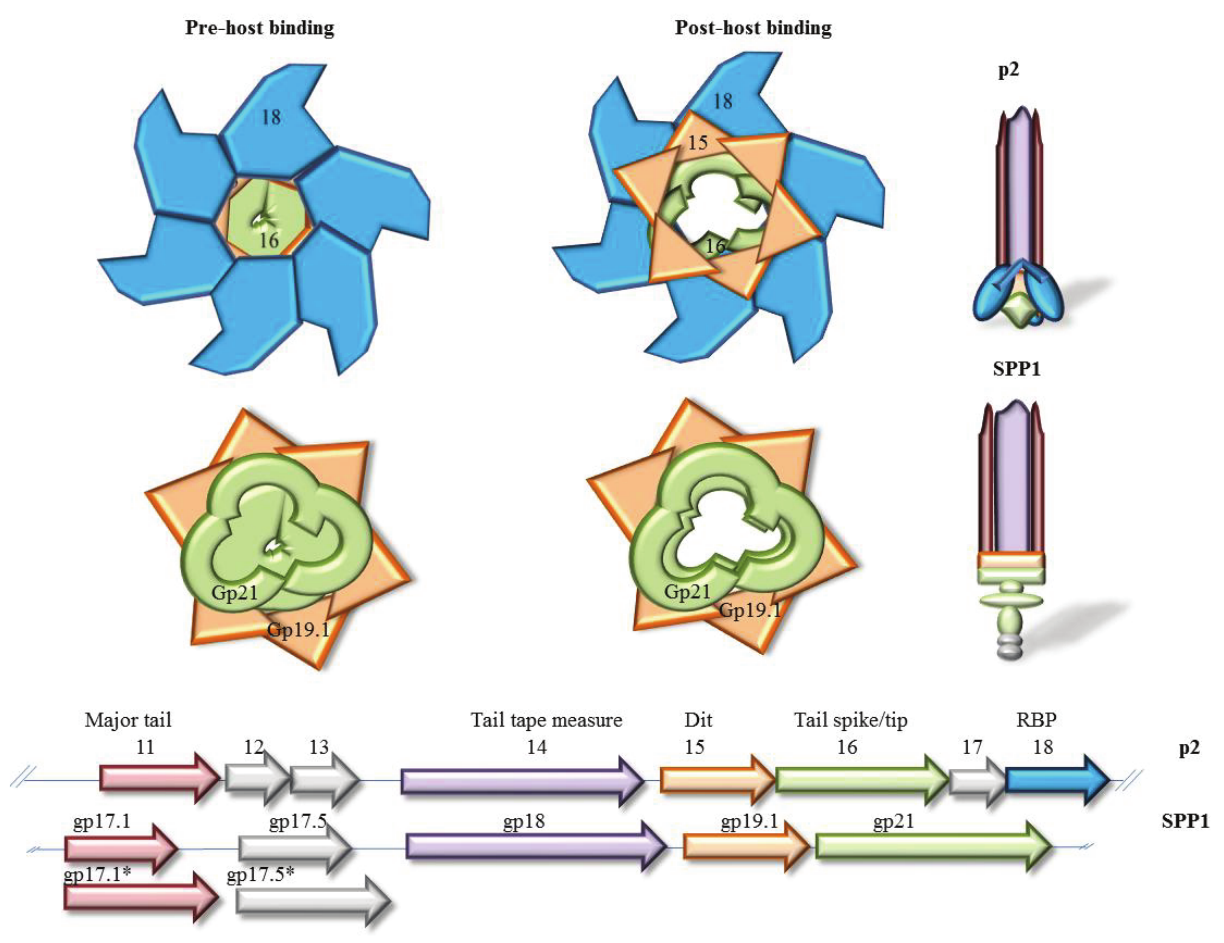
Figure 1. Schematic representation of a top view of the re-organisation of the p2 (top) and SPP1 (bottom) baseplate regions before (right) and after (left) binding to the host cell. The p2 baseplate, composed of a hexamer of ORF15 (orange), a trimer of ORF16 (green) and six trimers of ORF18 (blue) which represents the RBP. In parallel, the SPP1 distal tail region is composed of two back-to-back hexamers of gp19.1 (orange) and a trimer of gp21 (green) bound to each of the Dit (gp19.1) hexamers, one trimer in the open conformation and the other in the closed conformation. A representation of the genomic regions that encode the tail structural components are presented in the lowermost section, including the genes encoding the proposed major tail protein (pink), the tail tape measure protein (purple), the distal tail protein (Dit)/hub protein (orange), the tail spike (SPP1) or tail tip (p2) (green) and the RBP (blue, p2). Those in grey encode non-structural proteins or have not been functionally